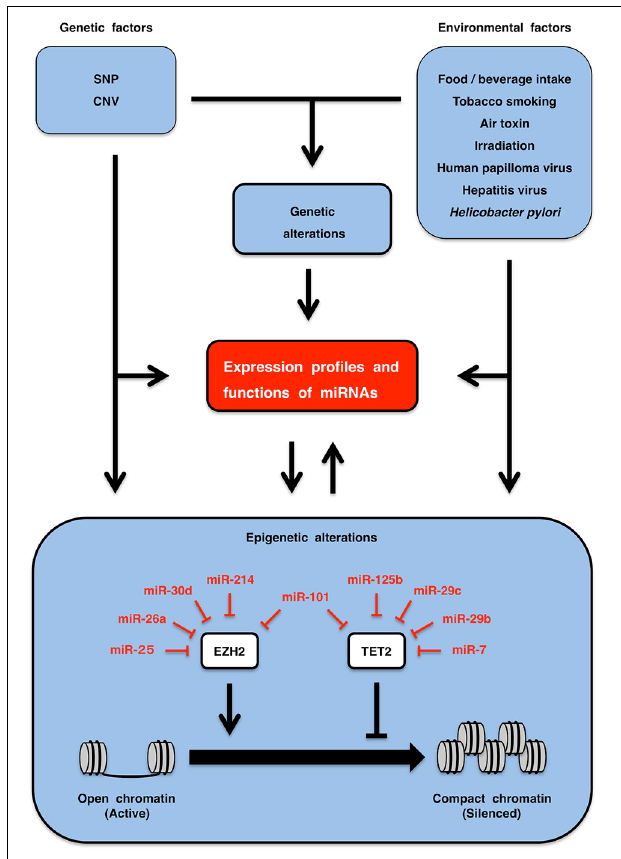
FIGURE 5 | Regulation of circulating miRNAs. Genetic factors, such as single nucleotide polymorphism (SNP) and copy number variation (CNV), as well as environmental factors, including life style (food/beverage intake, tobacco smoking, air toxin, irradiation, etc. ) and chronic infection (human papilloma virus, hepatitis virus, Helicobacter pylori, etc. ) are involved in the regulation of expression profiles and functions of miRNAs (upper part). EZH2 and TET2 are epigenetic regulators that are involved in inactivation and activation of genes through repressive histone marking and CpG-island de-methylation, respectively. miRNA expression is downregulated by epigenetic silencing, while epigenetic regulators are repressed by multiple miRNAs. miRNAs and epigenetics are in the relationship of mutual regulation (lower part). Genetic and environmental factors regulate circulation miRNA profiles directly as well as indirectly through genetic and epigenetic